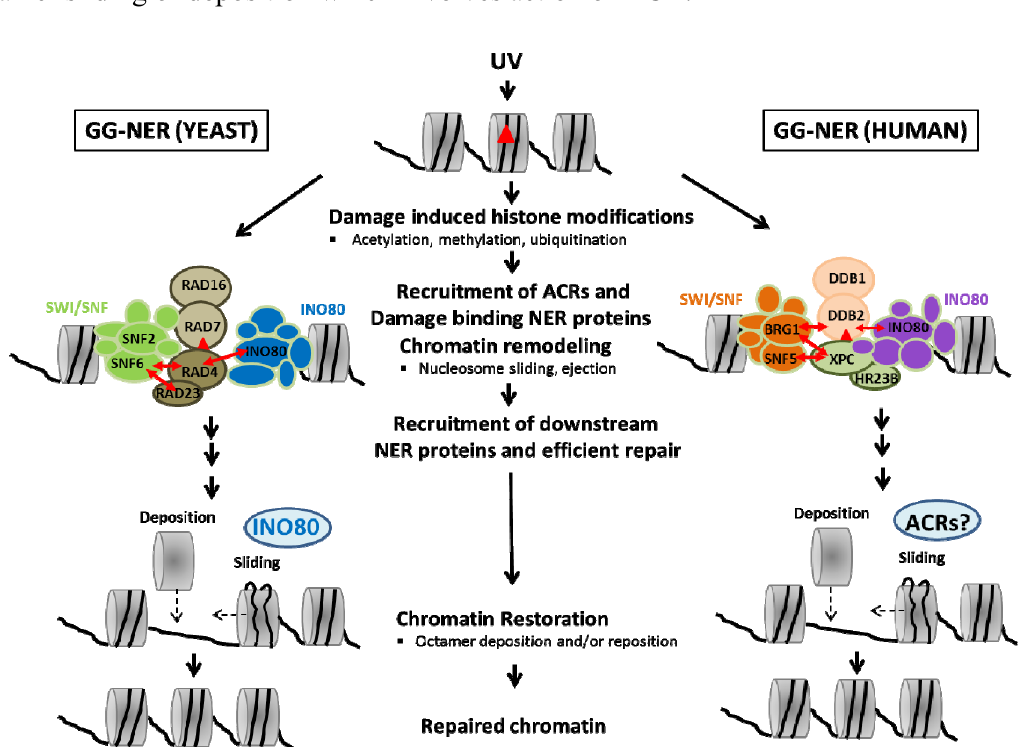
Figure 2. Model demonstrating involvement of ATP-dependent chromatin remodelers (ACRs) in Global Genome Nucleotide Excision Repair (GG-NER). UV DNA lesions (red triangle) induce variety of histone modifications such as acetylation, methylation, ubiquitination. These modifications serve as signals for recruitment of ACRs and damage binding NER proteins to the damage site. The early Nucleotide Excision Repair (NER) proteins (Rad7/Rad16 and Rad4-23, DDB2/DDB1 and XPC, HR23B) arrive at the damage site, recognize and specifically bind UV lesions. Chromatin remodelers, SWI/SNF and INO80 are recruited by histone modifications and/or interactions with damage binding proteins (red double head arrows). Yeast and human ACRs are distinguished by color coding. Yeast SWI/SNF (light green), human SWI/SNF (orange), yeast INO80 (dark blue), human INO80 (purple). Remodelers catalyze chromatin remodeling (nucleosome sliding, ejection), facilitate accessibility of damaged DNA and help recruitment and assembly of the downstream NER repair proteins. The UV lesions are efficiently removed. Chromatin structure is restored to the original state potentially by nucleosome rearrangements such as octamer sliding or deposition which involves action of